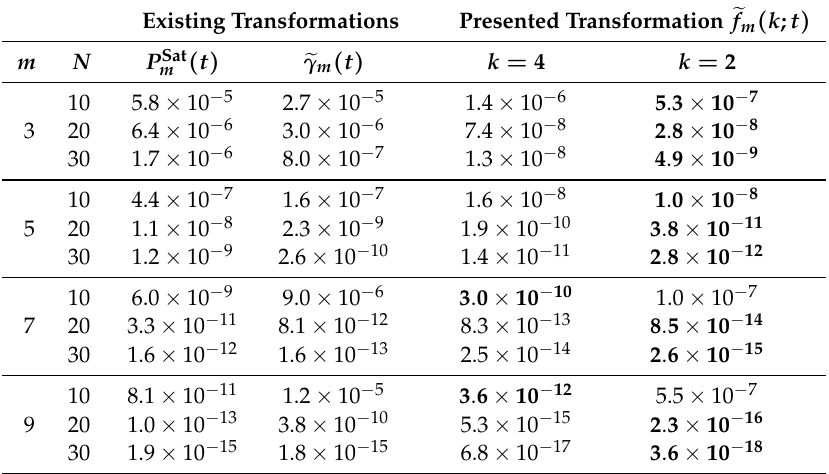
Table 2. Relative errors of the N -point Gauss-Legendre quadrature rule corresponding to the existing transformations P Sat m ( t ) , (cid:101) γ m ( t ) and the presented transformation (cid:101) f m ( k ; t ) for the end-point weakly